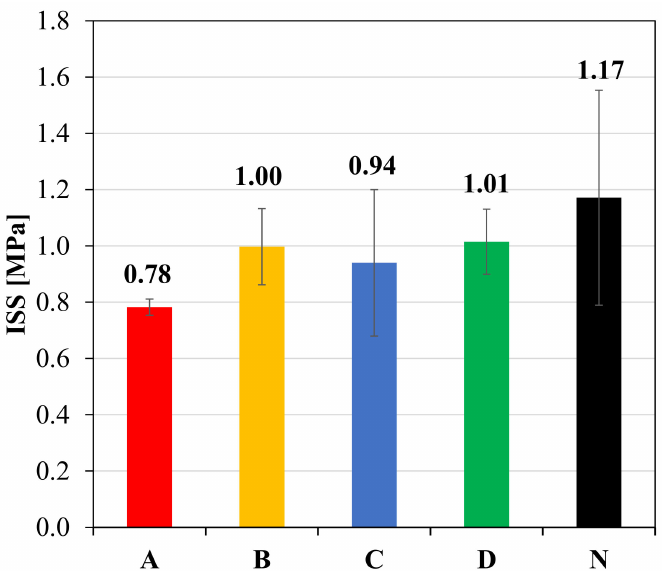
Figure 6. Average ISS values with error bars from Leutner